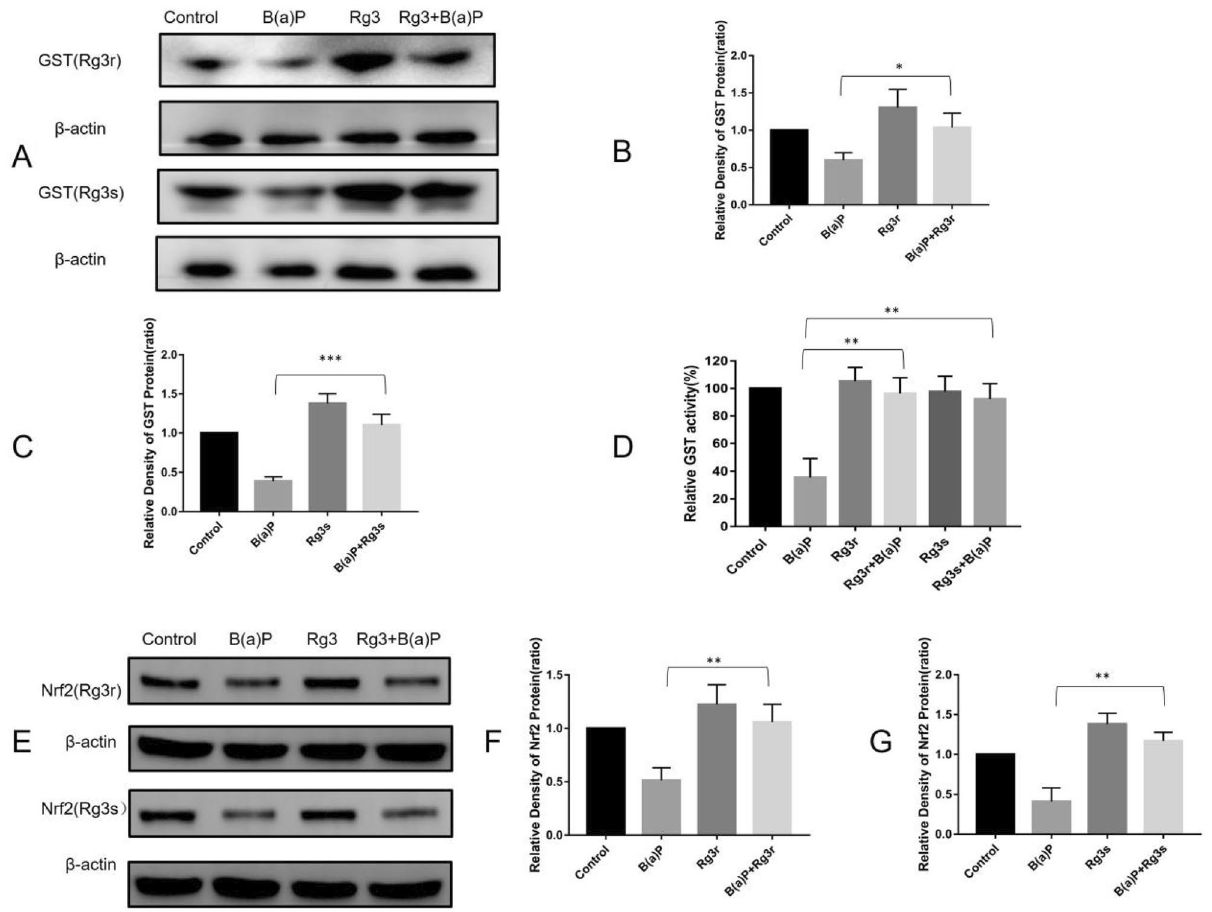
Figure 6. Expression of GST and Nrf2 in hEL cells treated with B(a)P and G-Rg3. ( A ) GST expression was detected by western blotting. ( B ) Quantitative GST expression in hEL cells treated with B(a)P and G-Rg3r. ( C ) Quantitative GST expression in hEL cells treated with B(a)P and G-Rg3s. ( D ) GST activity of hEL cells treated with B(a)P and G-Rg3. ( E ) Nrf2 expression detection by western blotting. ( F ) Quantitative Nrf2 expression in hEL cells treated with B(a)P and G-Rg3r. ( G ) Quantitative Nrf2 expression in hEL cells treated with B(a)P and G-Rg3s. The data is presented as the mean ± SD of triplicate assays. * P < 0.05, ** P < 0.01, *** P <